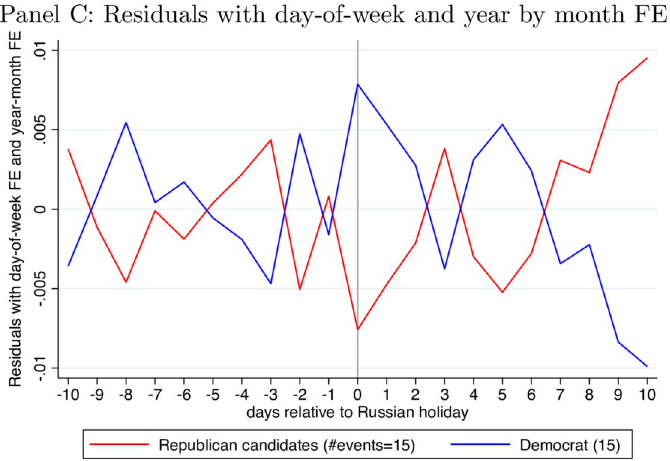
PLOS ONE | https://doi.org/10.1371/journal.pone.0264507 March 30,